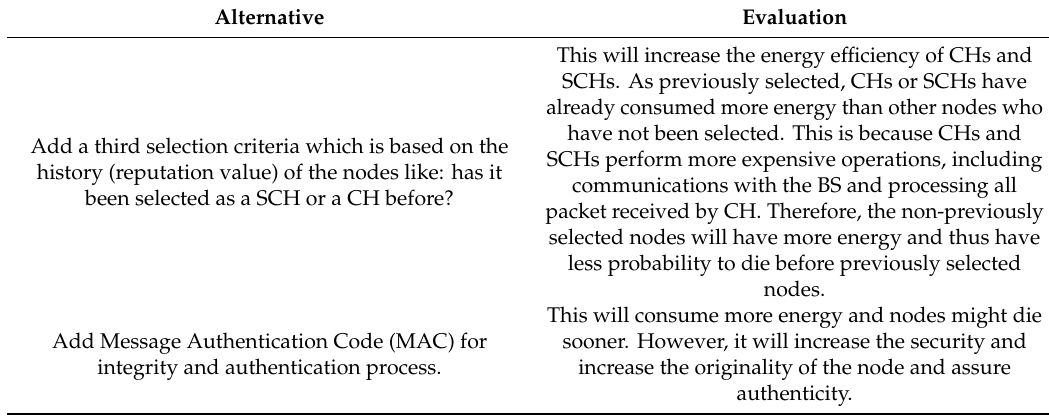
Table 5. Identified